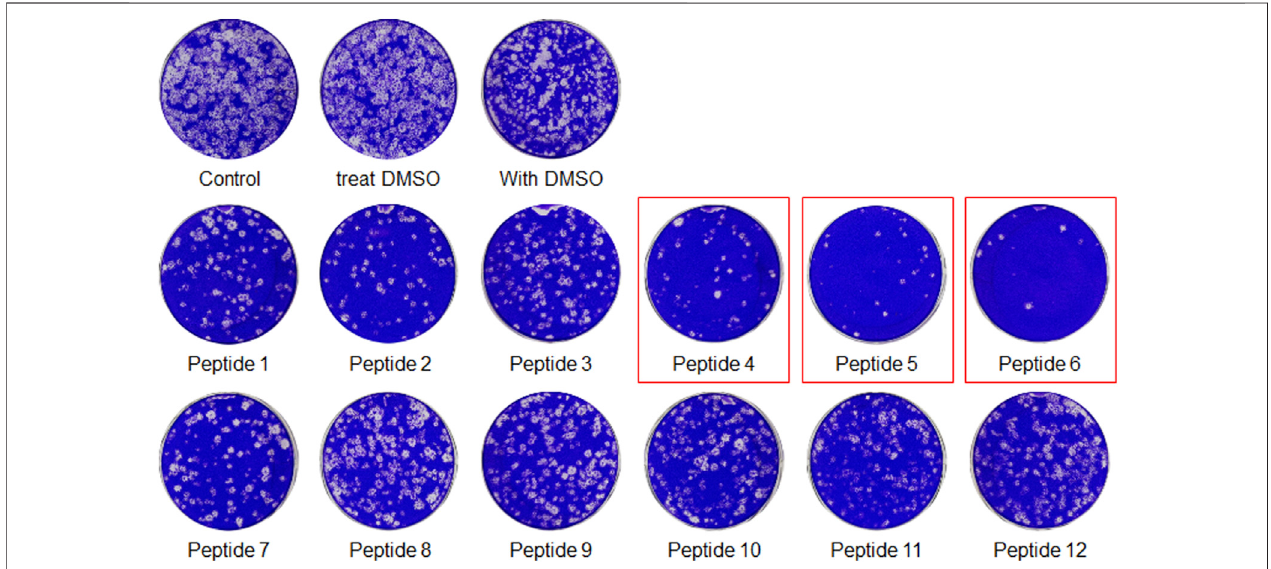
FIGURE 4 | The plaque formation assay for MERS-CoV inhibitor peptides. MERS-CoV was pre-incubated with 10 µM of each peptide for 30 min at 37 ° C. The mixtureofthevirusandeachpeptidewasaddedtotheVerocellsandincubatedfor1 h.Aftertheincubation,themediumwasreplacedwithDMEM/F12containing0.6% oxoidagar.Theplaqueswerestainedwithcrystalviolet 4 days after infection. Plaquenumber wasquanti fi edand relative production ofviralparticles isshown,withvirus production of a DMSO-treated control representing 100%.